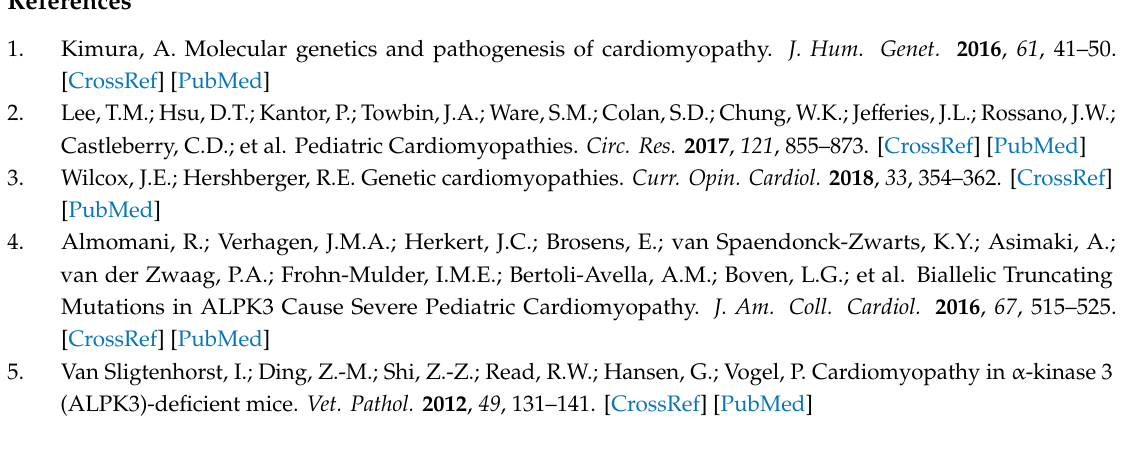
Figure S1: Histological staining of myocardial biopsy of patient 2, Table S1: Targeted panel of 108 cardiomyopathy-associated genes, Table S2: Targeted panel of 173 cardiomyopathy-associated genes, Table S3: List of 220 genes associated with cardiac phenotypes, Table S4: Primers for verification of ALPK3 variants by Sanger